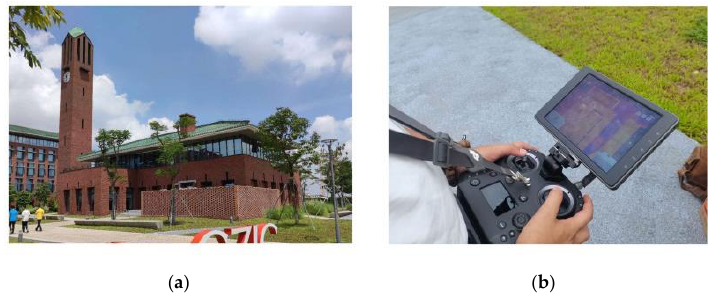
Figure 4. Images of ( a ) the building to be tested, ( b ) the operation panel of the UAV